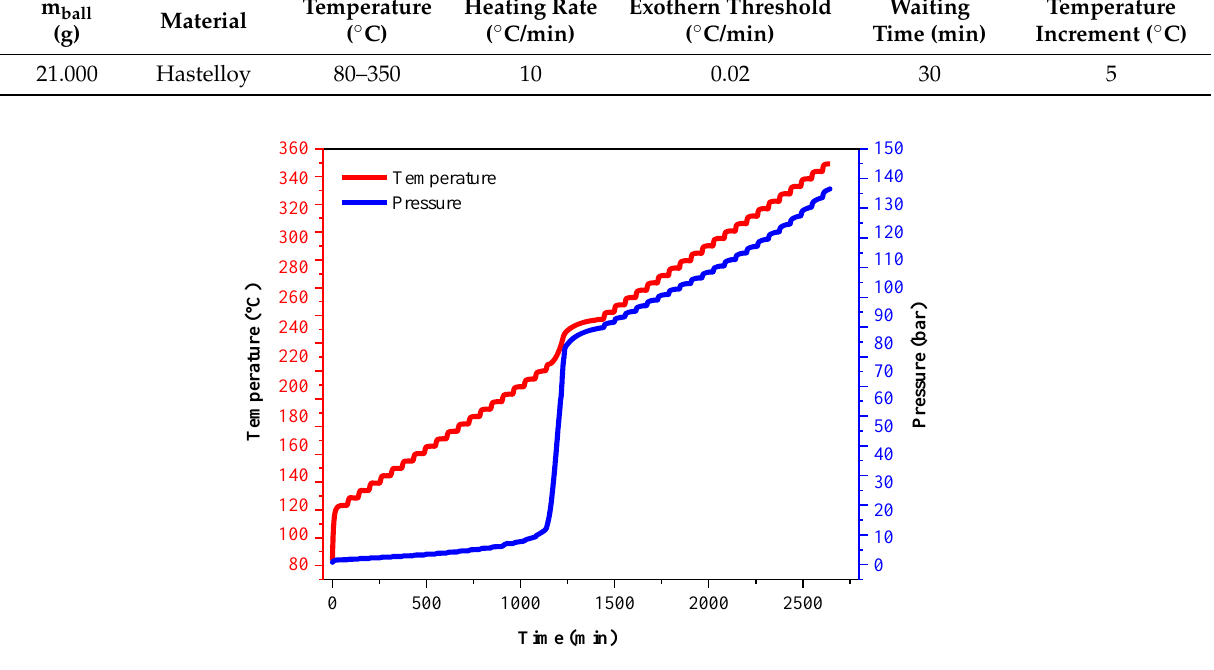
Figure 5. Temperature and pressure versus time curves of LP30 + PFPN.